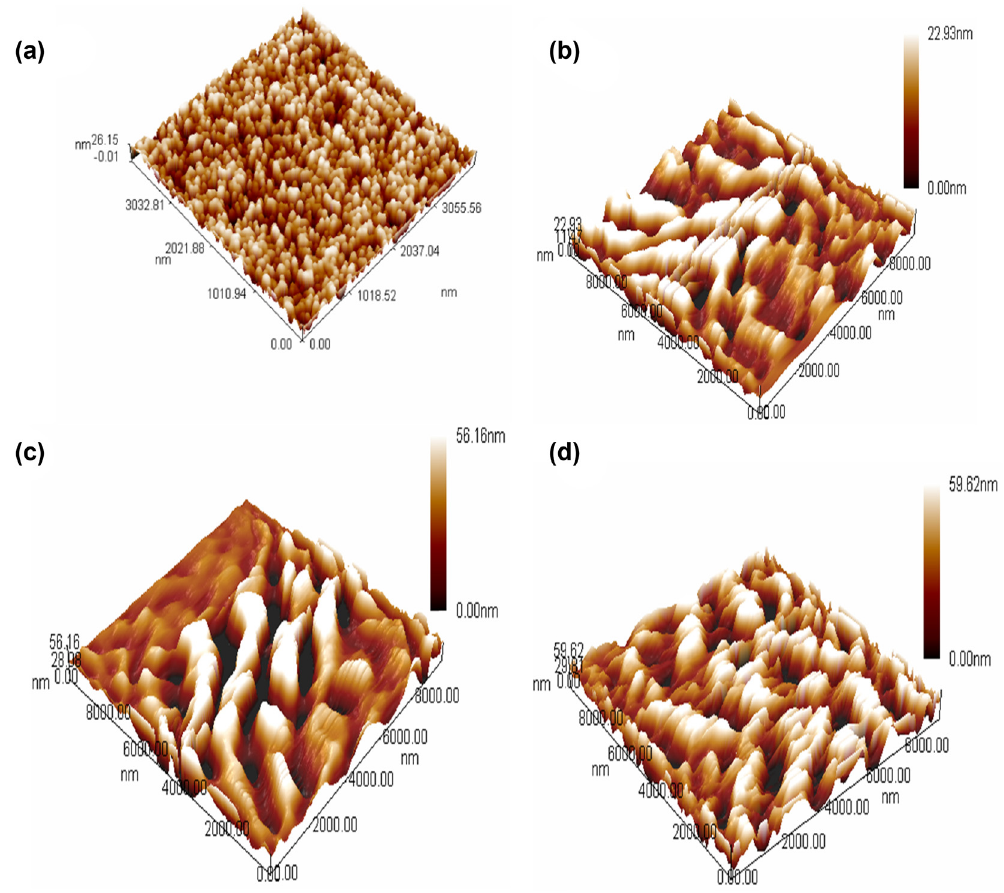
Figure 4: AFM pattern of a sample: ( a ) SS, ( b ) Ni – Pb, ( c ) Ni – Pb - 10ZrO 2 , ( d ) Ni – Pb - 20ZrO 2 .